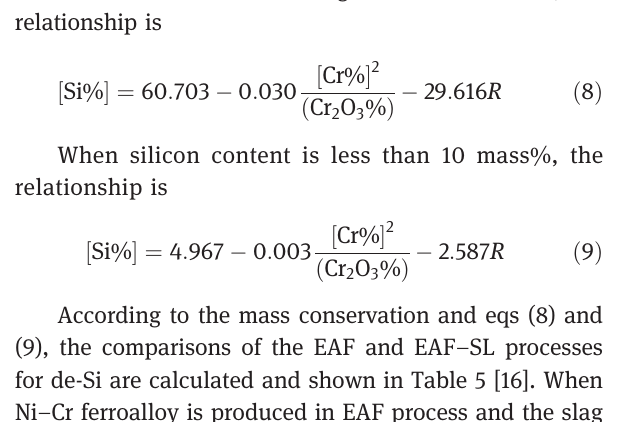
Table 5: Calculation of material balance for EAF and EAF – SL processes.